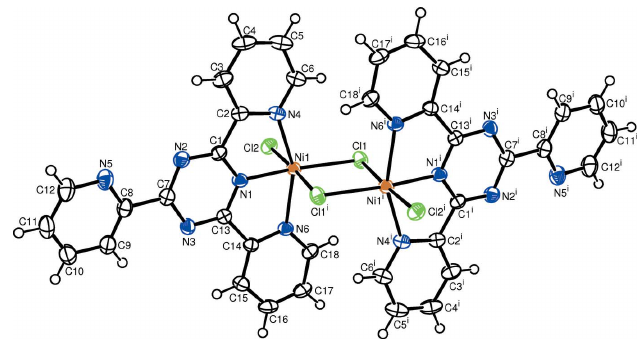
Figure 1 Molecular structure of the title compound showing the atom labelling and displacement ellipsoids drawn at the 50% probability level for non-H atoms. Symmetry code: (i) (cid:2) x , (cid:2) y + 1, (cid:2) z